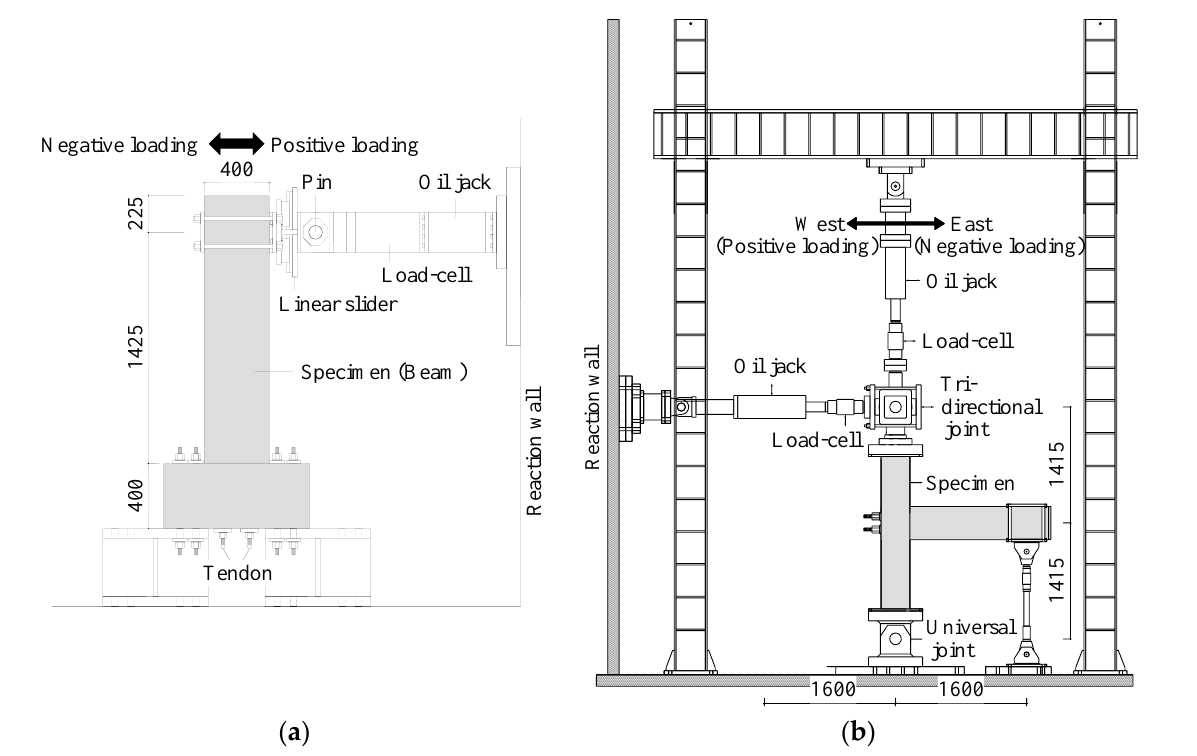
Figure 11. Test setup: ( a ) PCX01 and PCX02; ( b ) PCJ05 and PCJ06 (mm).